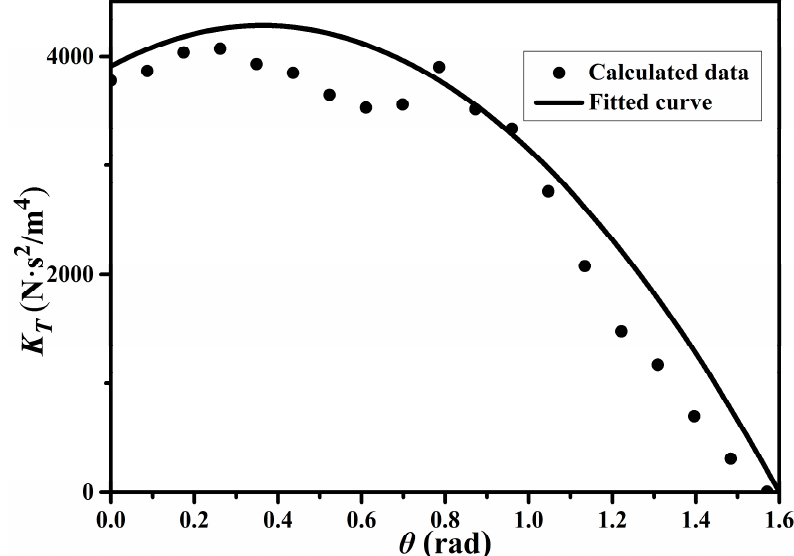
Figure 10. The value of K T as a function of the angle of the paddle θ . Points are the values of K T by calculation and cure is the fitted cure of K T .